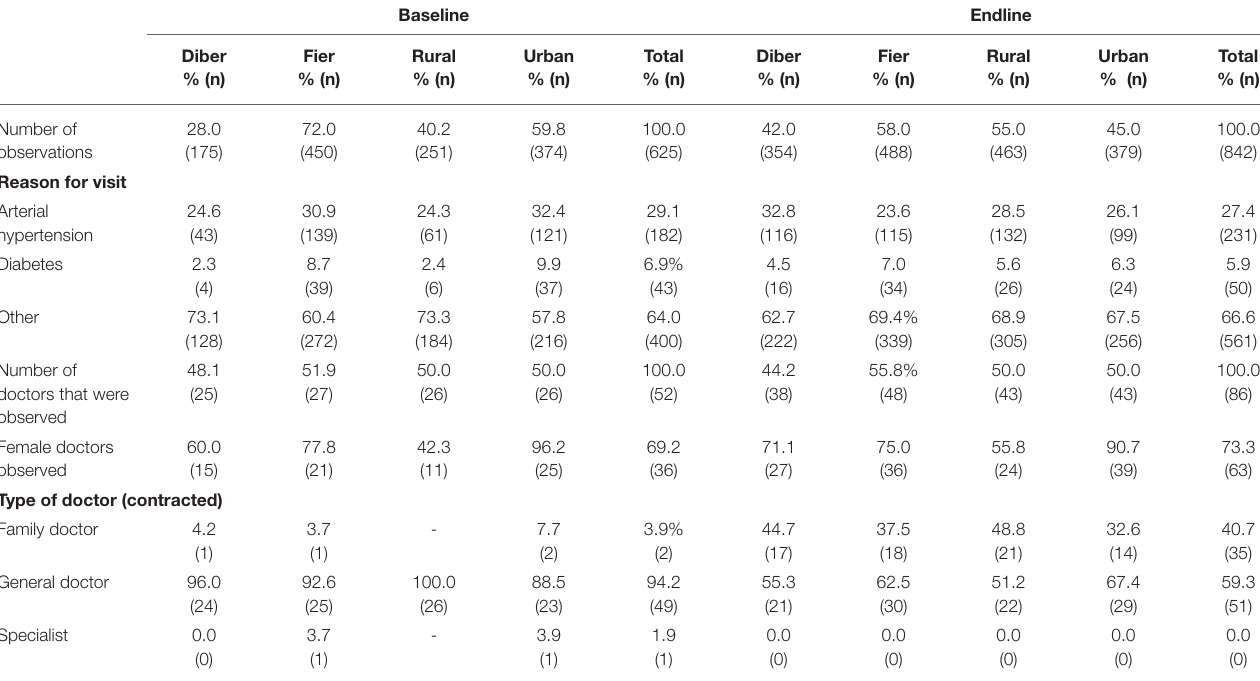
TABLE 1 | Observations and socio-demographic attributes of doctors of clinical consultations.